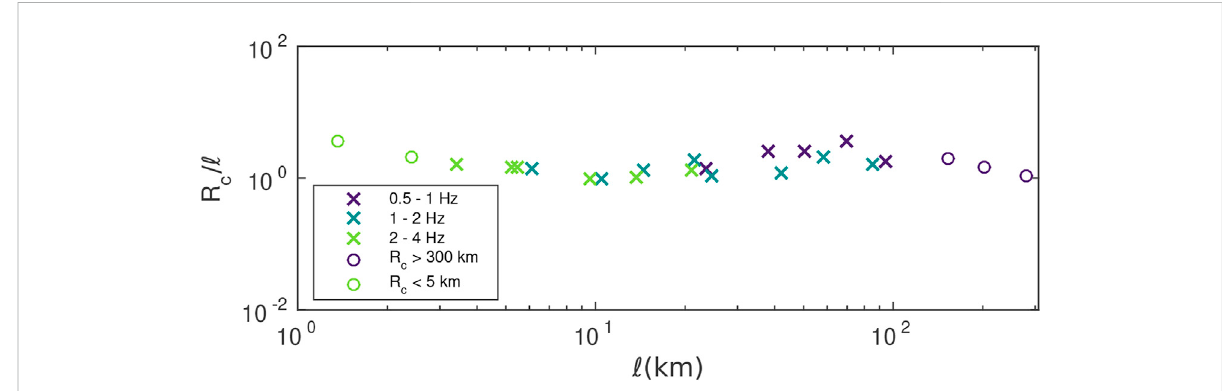
FIGURE 12 Scaled critical distance R c / ℓ as a function of ℓ . Colors stand for thethree frequency bands. The circles denote thecases atwhich R c takes values either larger than the maximum epicentral distance (300 km) or shorter than the minimum (5